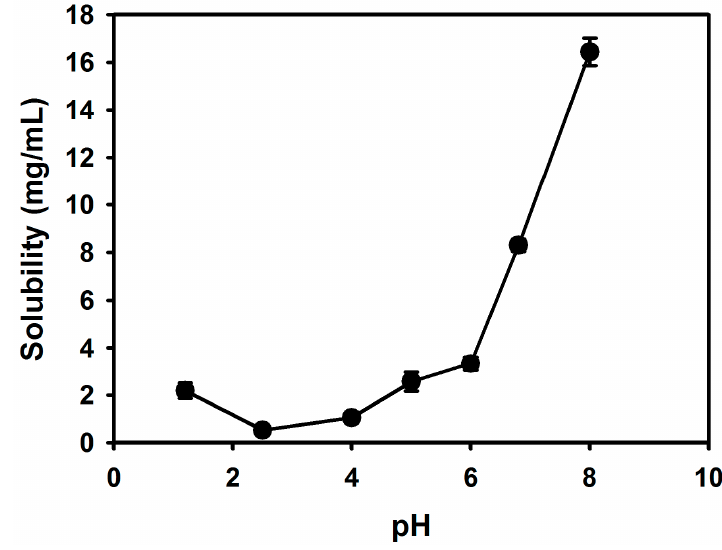
Figure 2 . The pH-dependent solubility of cefdinir.